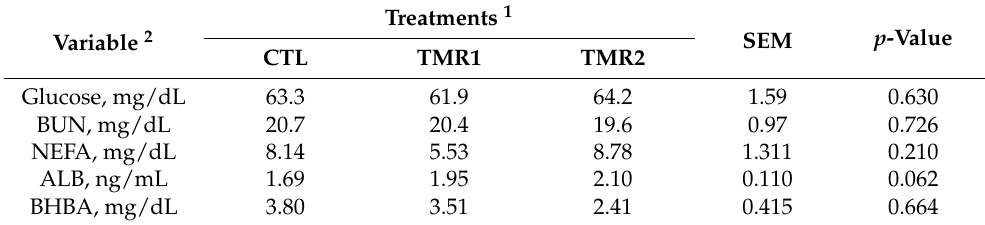
Table 5. Concentrations of blood plasma